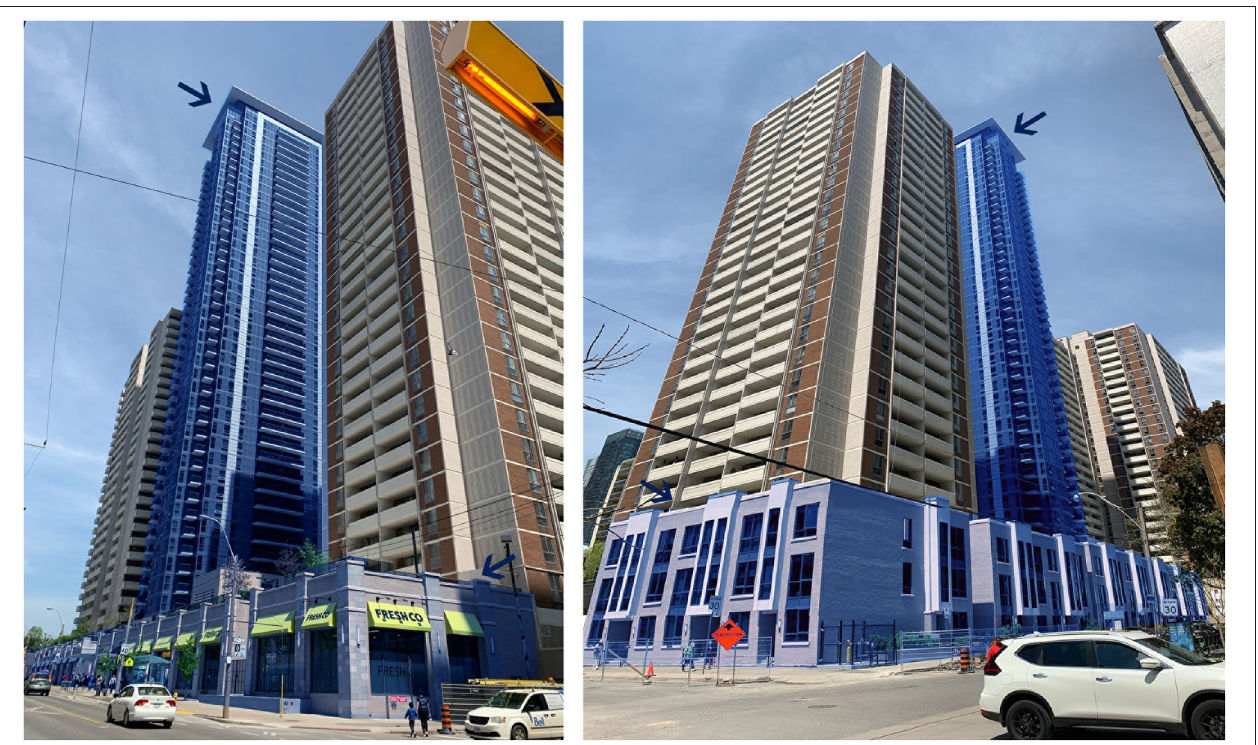
FIGURE 9 | Infill development (the displacement of open spaces with new constructions) in the North St. James Town. Blue highlights show the new developments (photo credit: Luna